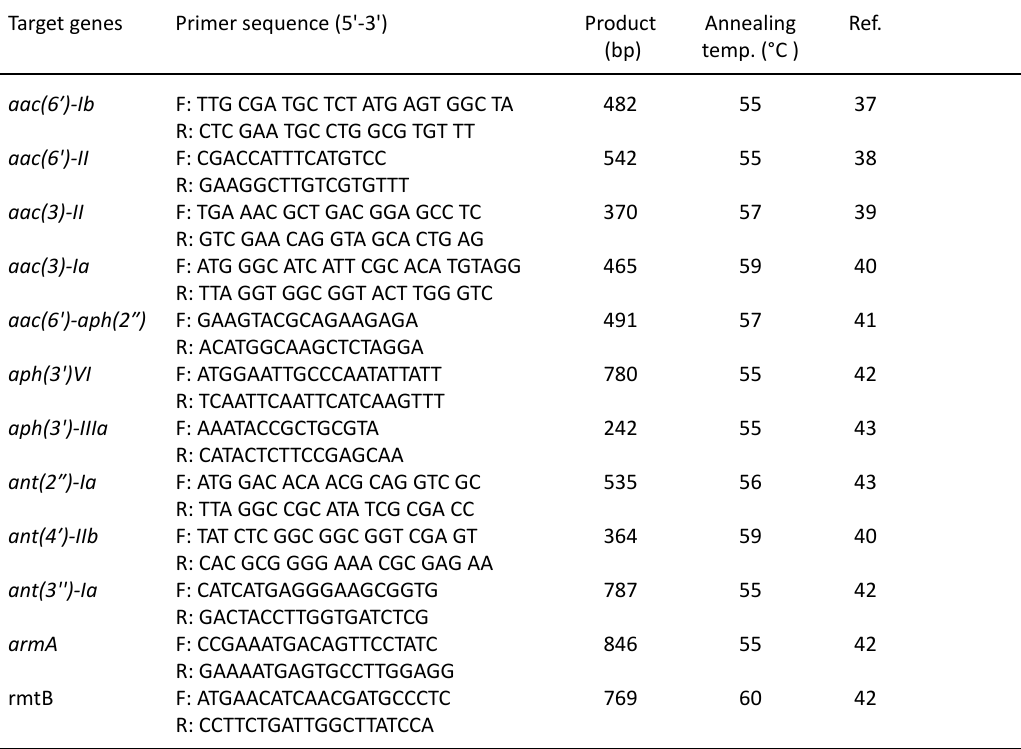
Table 1. Sequences of primers used for detection of AMEs and 16S-RMTases genes Target